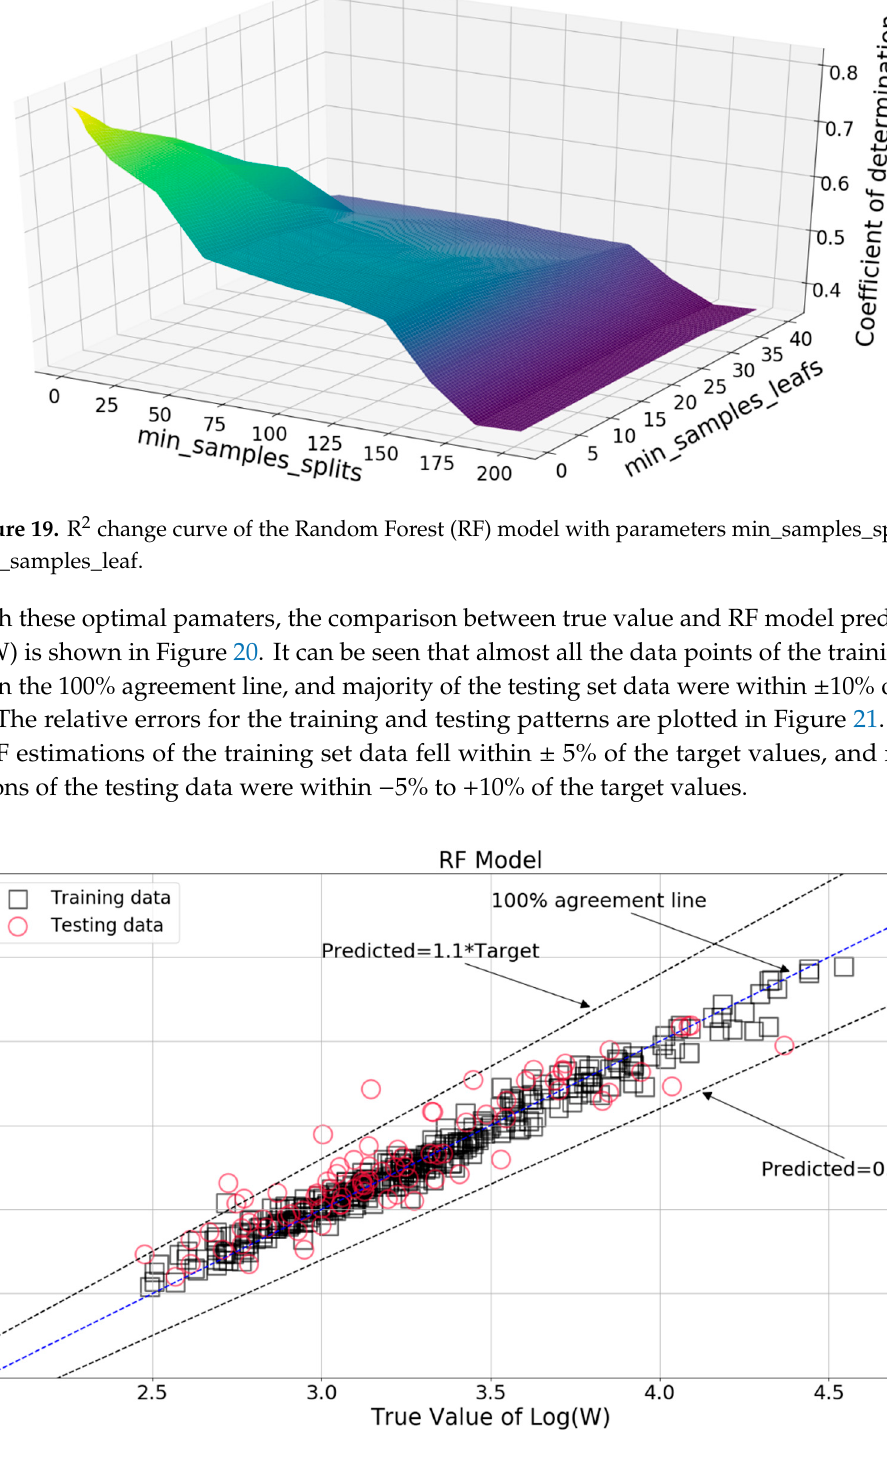
Figure 20. Comparison between the target and RF model predicted Log(W).